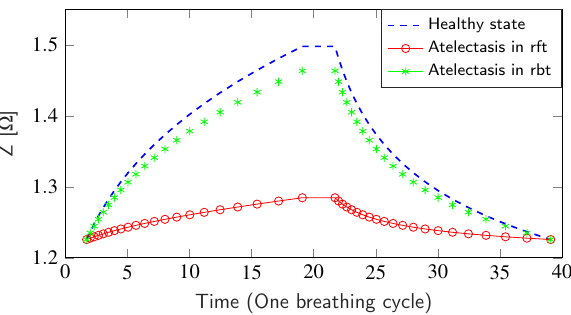
(a) Simulation result for an impedance measurement focused on the ROI rft during one breathing cycle. The absolute value of the complex impedance is presented. In blue, all lung regions were in healthy state. In red, an atelectasis was simulated in the focused ROI rft. In green, atelectasis was simulated in the adjacent region rbt.